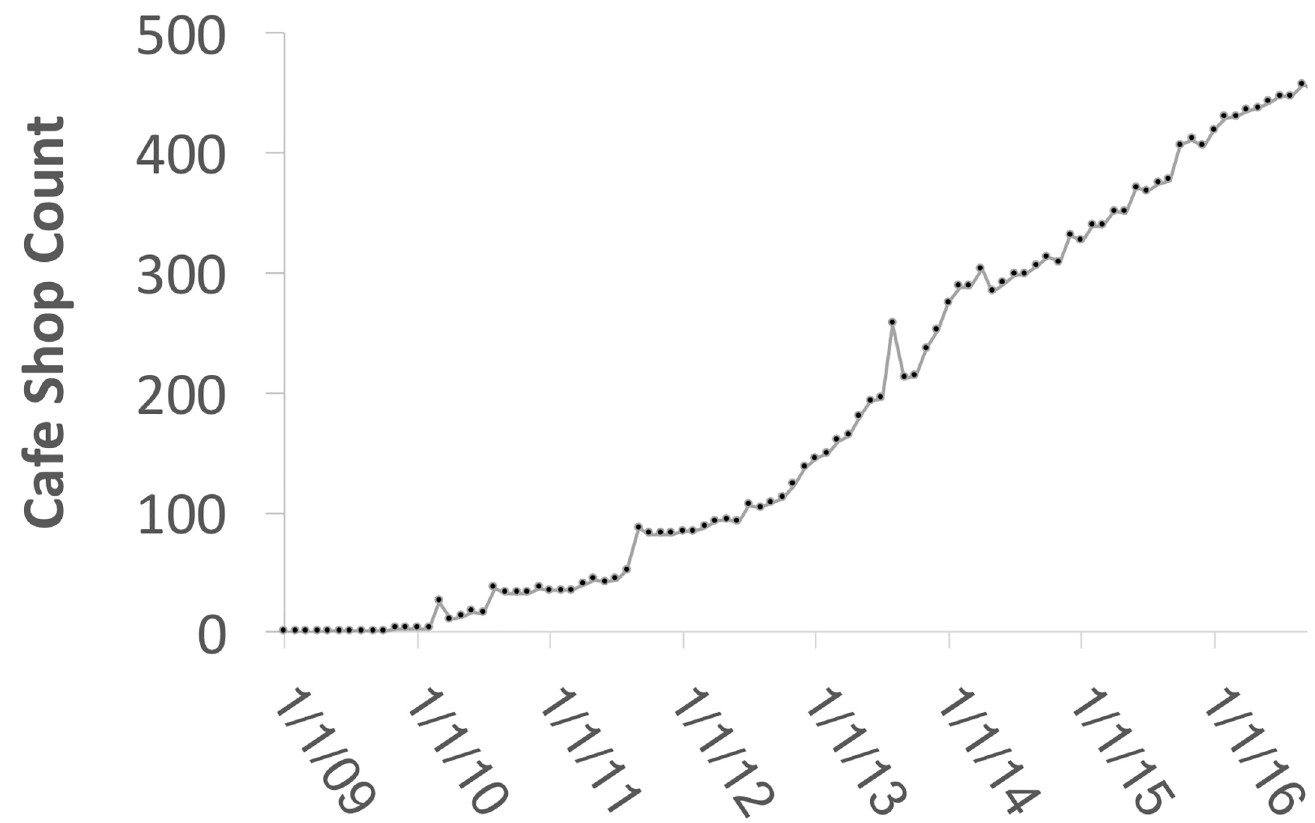
Fig 2. Coffee shop count in Manhattan from OSM—Monthly 1/1/2009–11/31/2016.